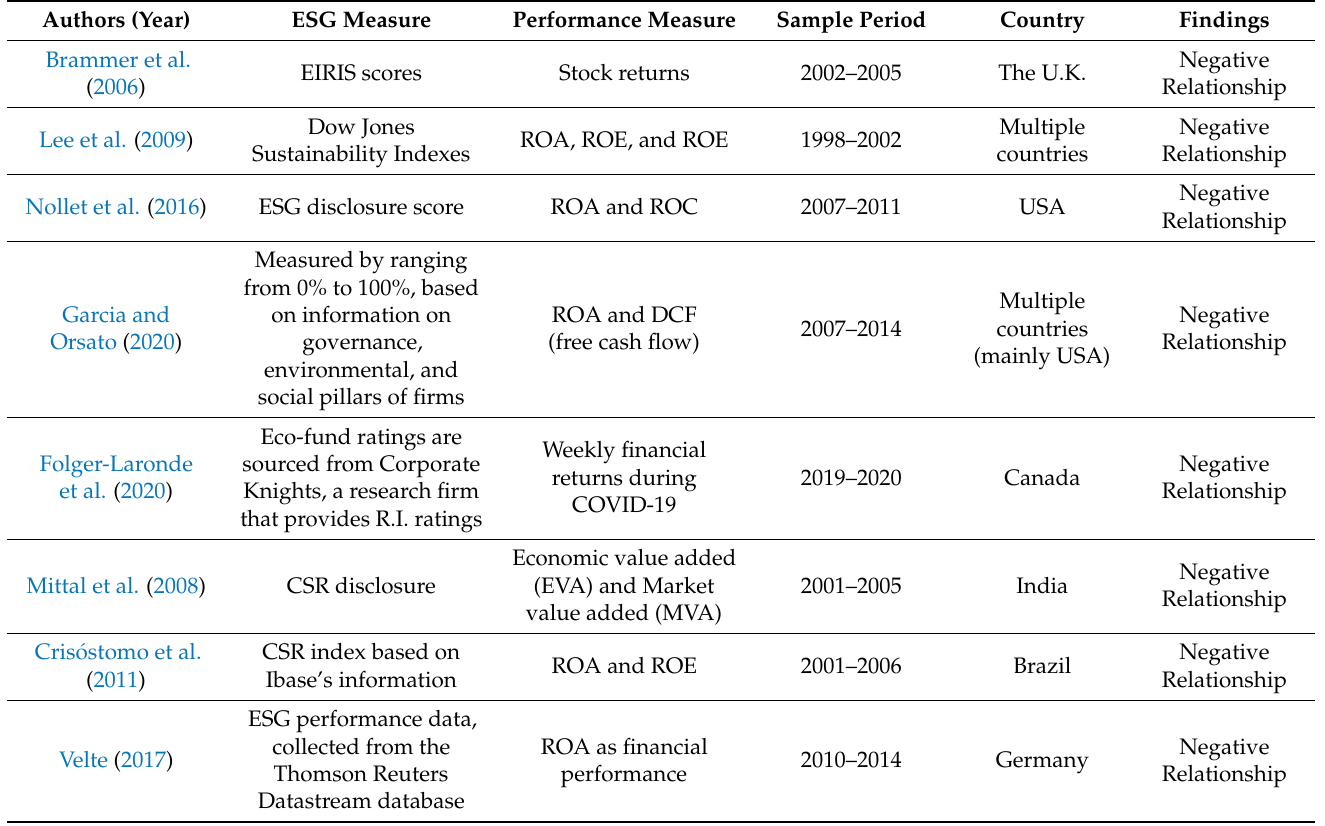
Table 2. Literature on the negative association between ESG and